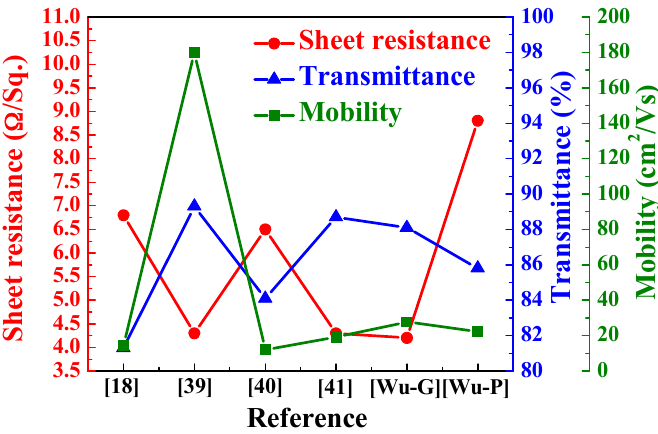
Figure 11. Performances of the α -IGZO/Ag/ α -IGZO films as compared with the data in the